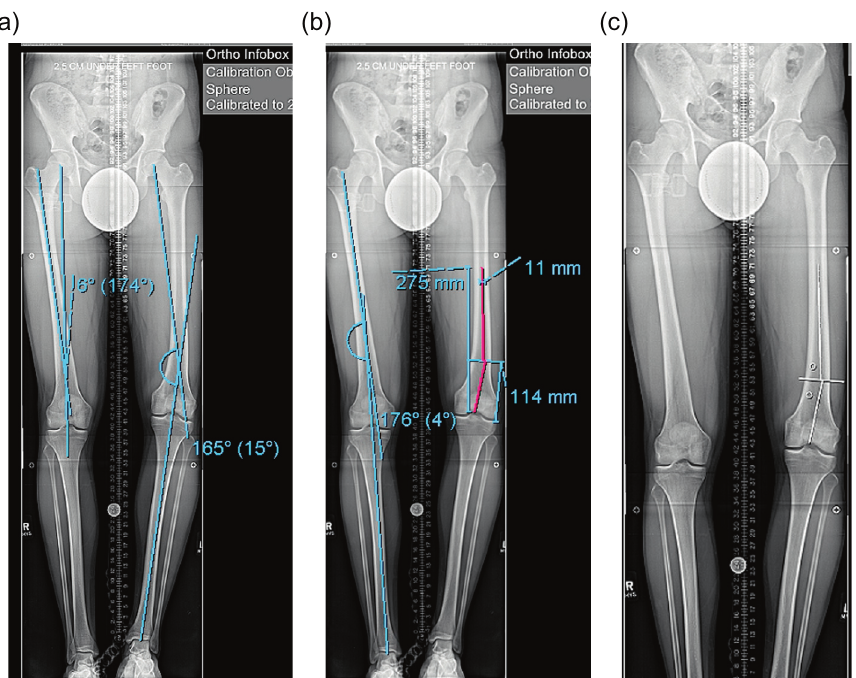
Figure 2. (a) This 51 inch AP radiograph allows for deformity planning with correction of varus and shortening. The mechanical axis planning is used to determine the magnitude and location of the deformity. (b) The red lines show the planned path of the ILN that will ensure correction of mechanical axis. The lines also show the length of the nail. (c) The white lines are placed to designate the path of the nail, and the circles are used to mark the location of the blocking screws. These radiographic plans are brought into the OR for comparison with intraop fluoroscopy